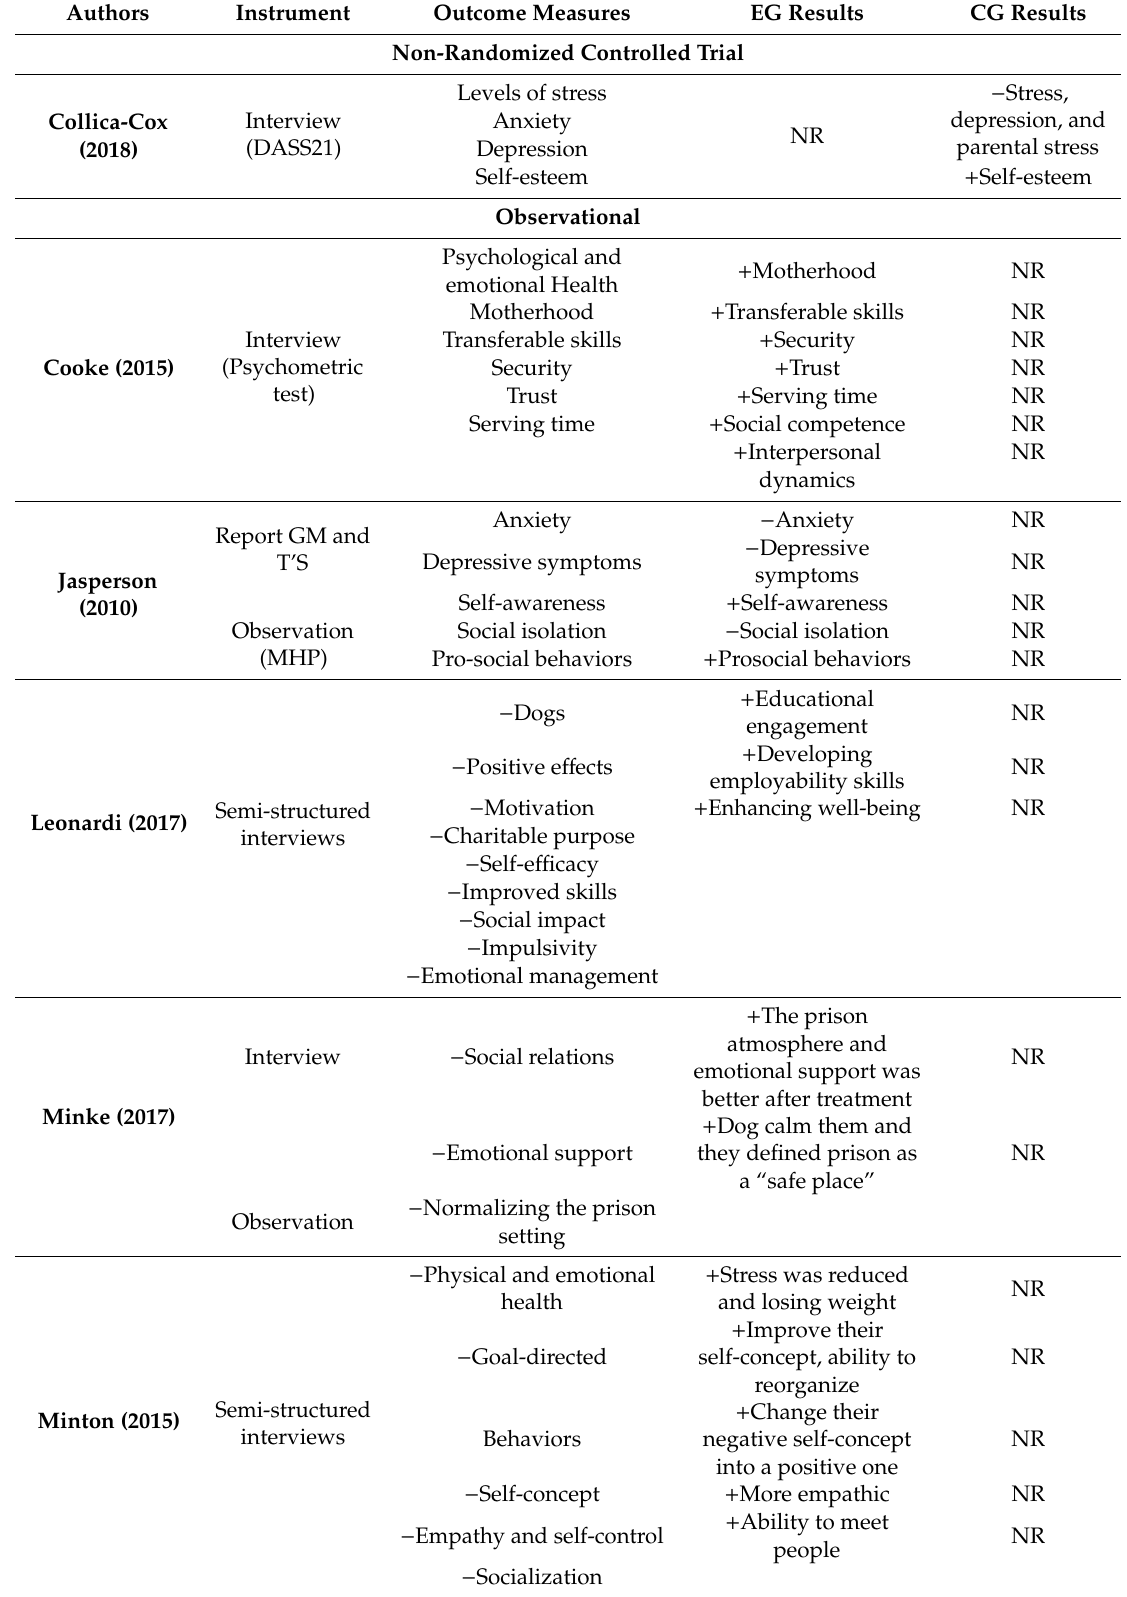
Table 5. Results synthesis qualitative